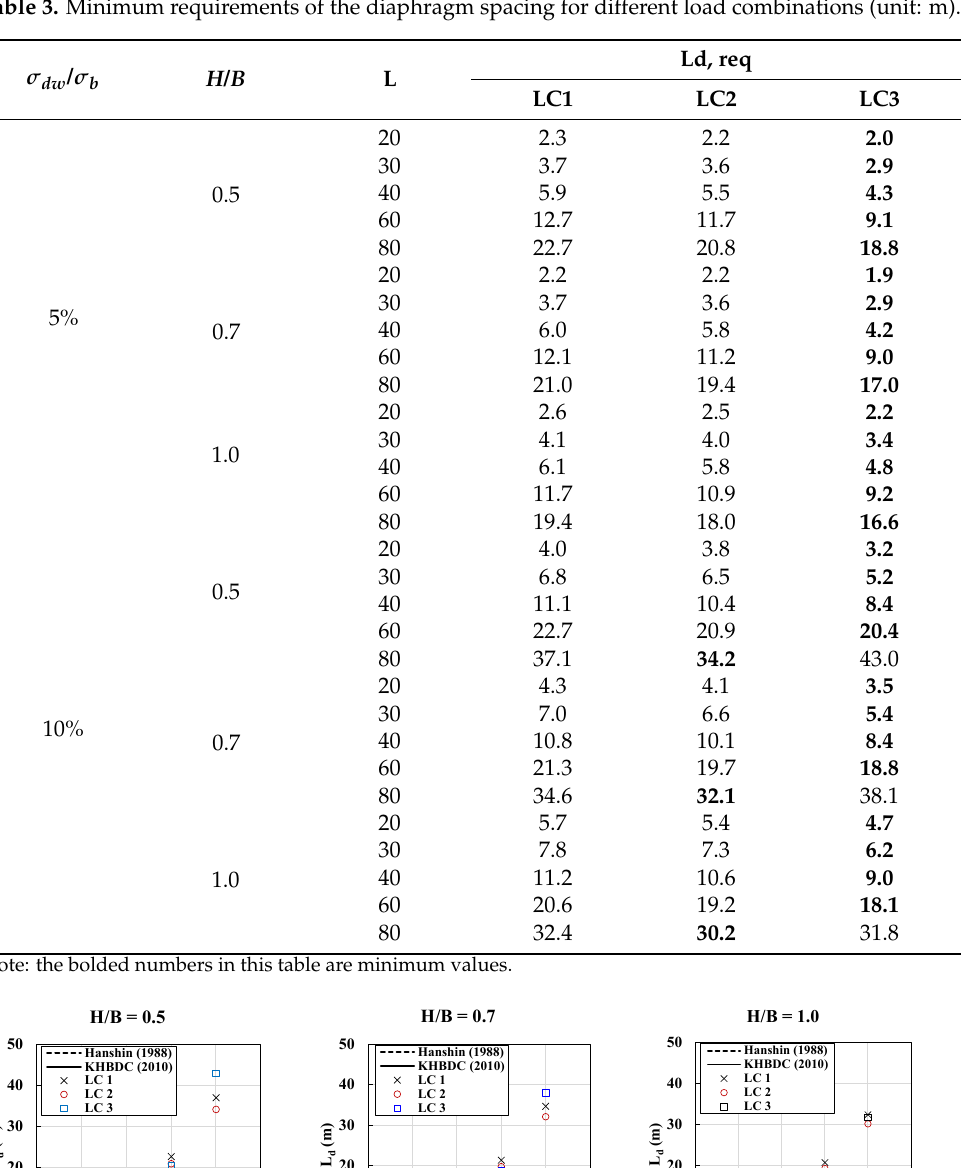
Table 3. Minimum requirements of the diaphragm spacing for different load combinations (unit: m).